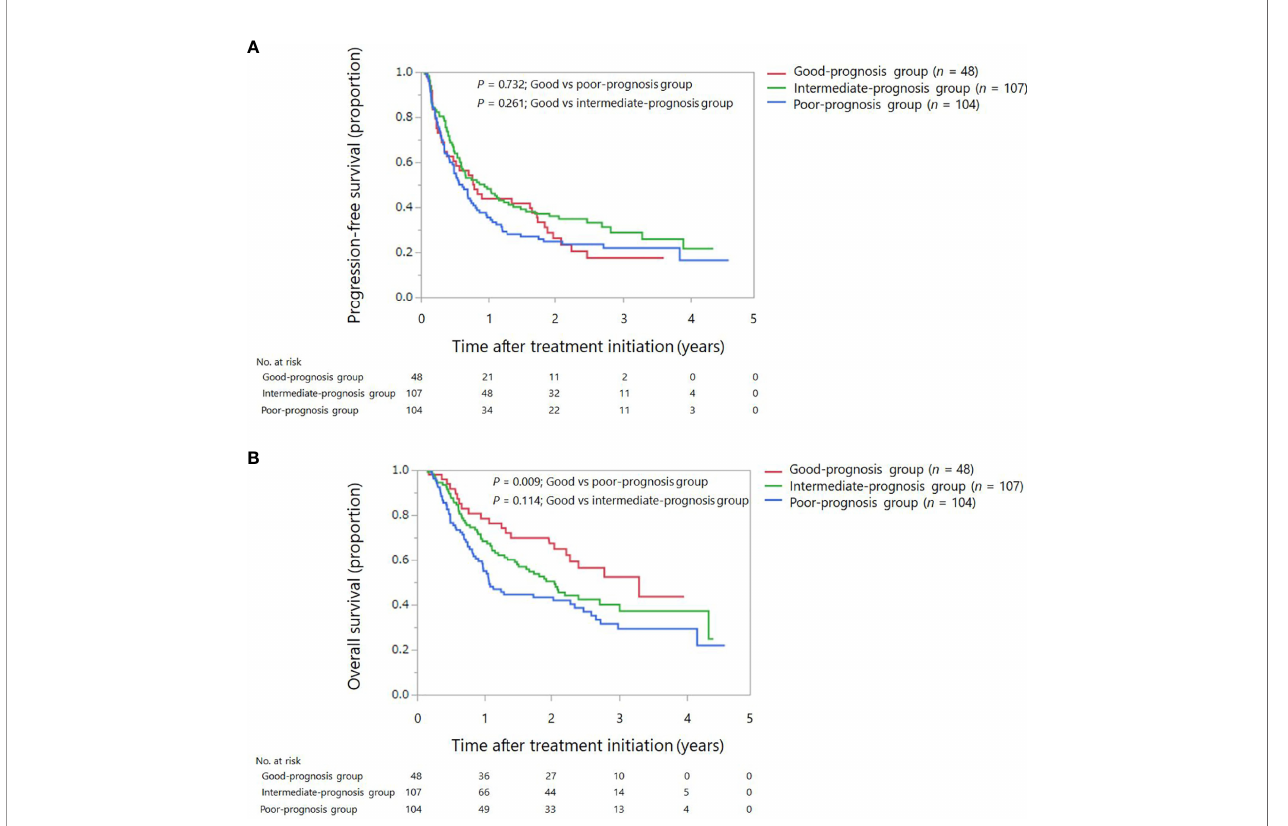
FIGURE 2 | Kaplan – Meier survival curves for progression-free survival and overall survival among the three groups: good, intermediate, and poor-prognosis scores. (A) Progression-free survival. (B) Overall survival.